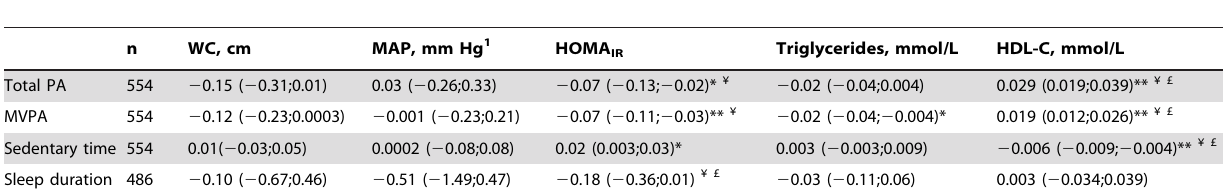
Table 3. Associations between changes in movement behaviors and changes in cardio-metabolic risk markers over a 200-day follow-up period in Danish